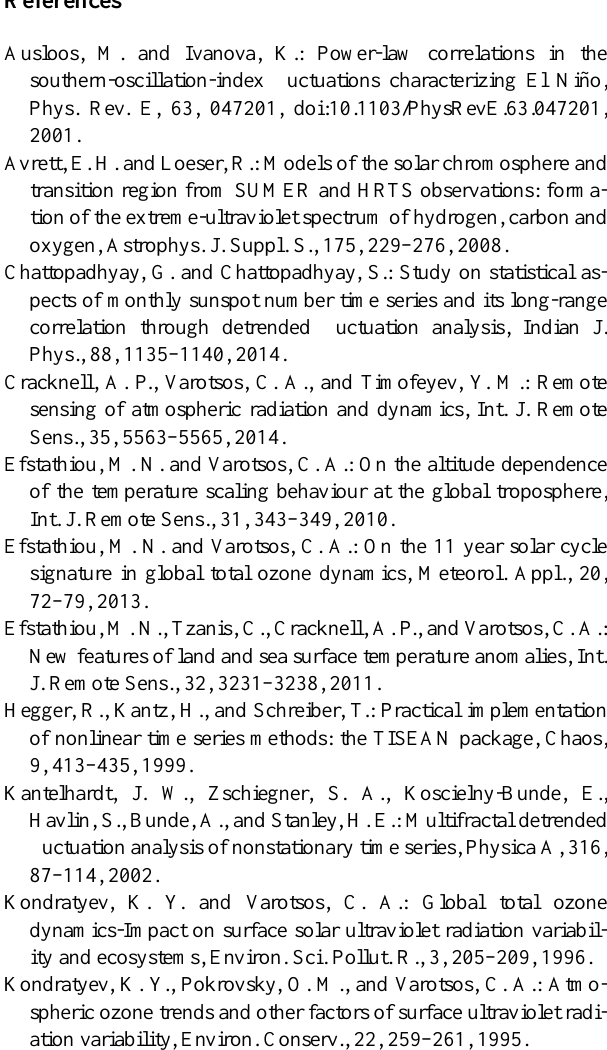
Figure 4. (a) Log-log plot of the root mean square fluctuation func- tion F d (τ) of the detrended SIF vs. the WL segment size τ for DFA-1 together with corresponding least-squares fits for τ ≤ 15nm (blue) and τ > 20nm (green). (b) Power spectrum using the MEM for the detrended SIF data set with the two power-law behaviors fits β = 1 (blue) – from a least squares fit up to 20nm – and β = 1 . 46 (green) for the 1 /f and 1 /f 1 . 46 structure, respectively, vs. the